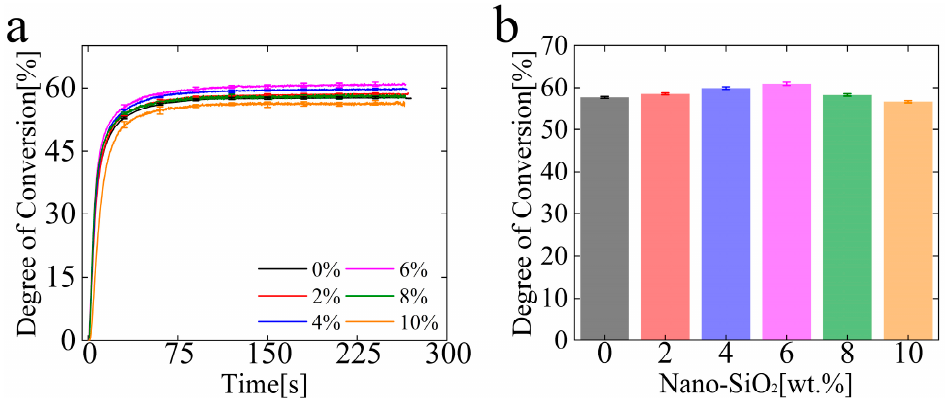
Figure 5. Results of the double-bond conversion. ( a ) Real-time development of the degree of conversion and ( b ) the final conversion of the composites with different nanoparticle content.